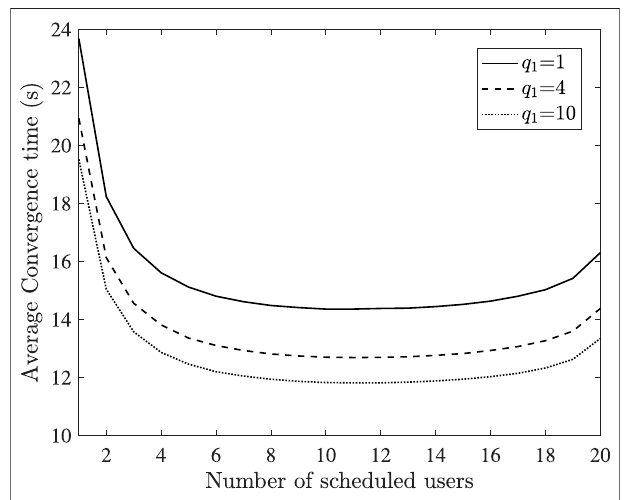
FIGURE 3 | Impact of number of scheduled users on the average convergence time of the FL